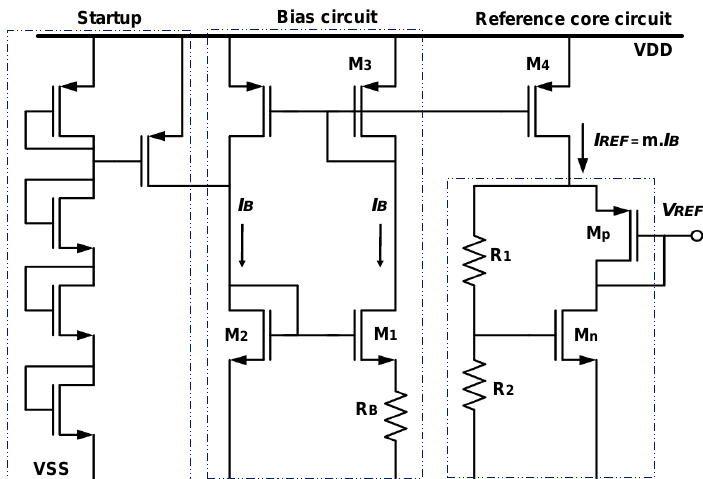
Figure 2. Voltage reference circuit adapted from